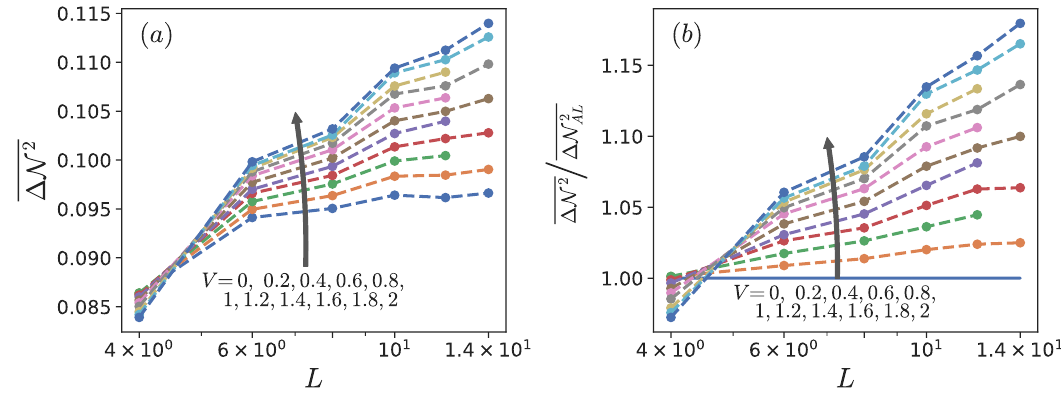
Figure 9: Same as Fig. 8 with the charge-density wave state as initial state instead of averaging over all initial product states. For L ≤ 10 the data is averaged over 50000 disorder realizations, 20000 for L = 12, and 10000 for L =